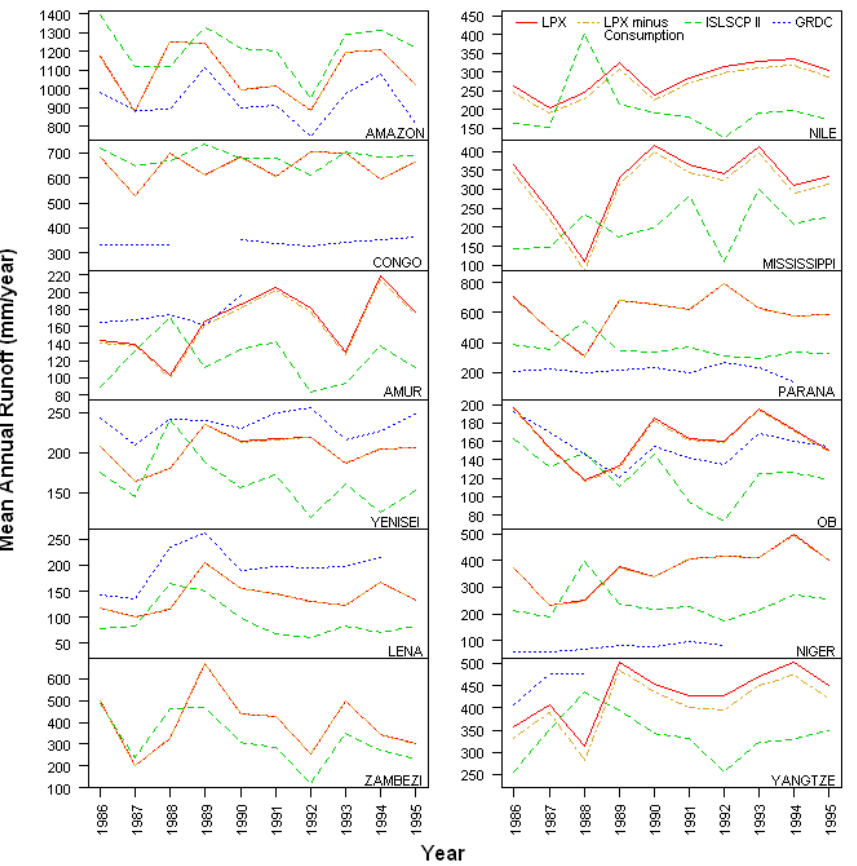
Fig. 5. Interannual variability in mean annual runoff for twelve selected catchments as represented by LPX, the ISLSCP II composite data and, where available, GRDC disaggregated river discharge observations. LPX simulated runoff with WaterGAP freshwater consumption is also